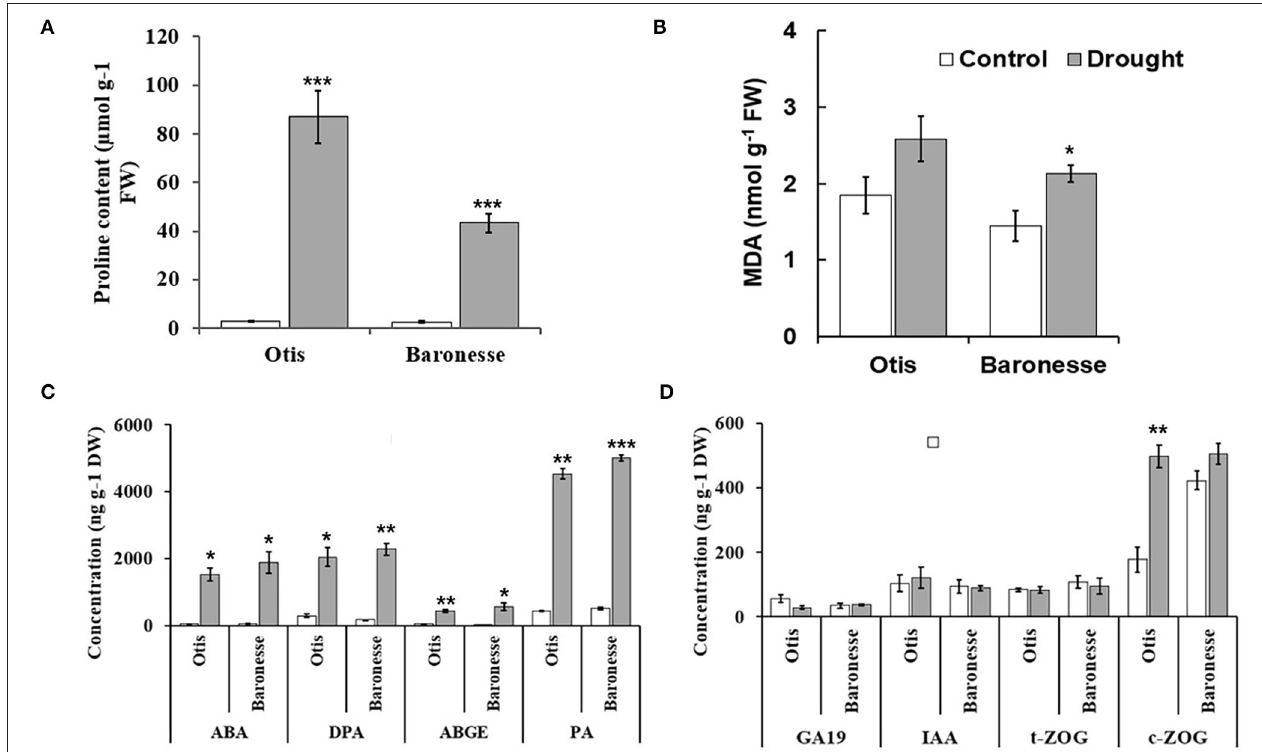
FIGURE 3 | Biochemical and hormonal profiles in Otis and Baronesse under drought stress. (A) Proline content. (B) Malondialdehyde (MDA) content. (C) Concentration of ABA and some of its metabolites (DPA, ABGE, and PA). (D) Concentration of Gibberellin 19 (GA19), Indole-3-acetic acid (IAA), trans-zeatin-O- glucoside (t-ZOG), and cis- zeatin-O-glucoside (c-ZOG). Hormones concentrations are the means of 3 biological replicates (each biological replicate is a pool of 10 plants). Bars represent standard errors of the means. * P < 0.05, ** P < 0.01, and *** P <